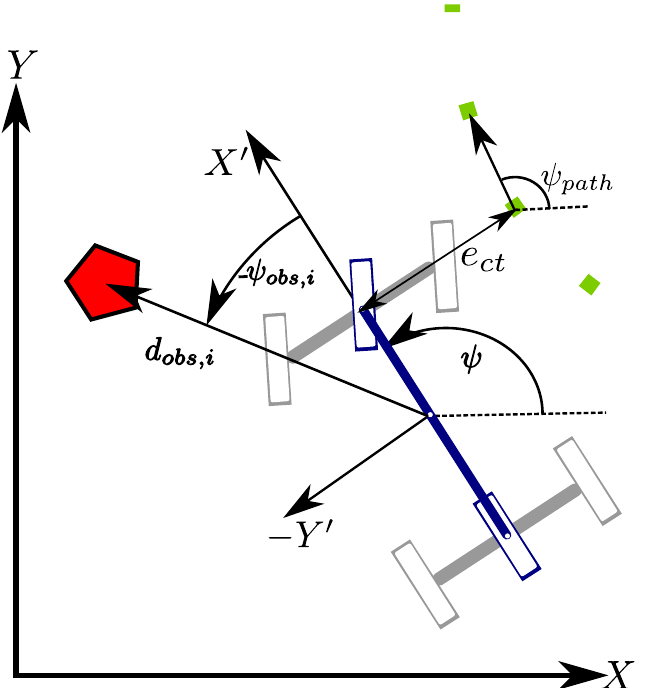
Figure 3. Coordinates systems for the mobile vehicle under the norm SAEJ670e. The coordinate system are placed on the C.G. of the vehicle in order to simplify the present